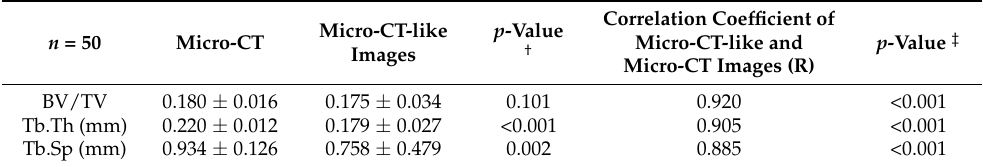
Table 4. Trabecular bone structure parameters and correlation coefficient (R) of micro-CT and pix2pixHD-derived micro-CT-like images.